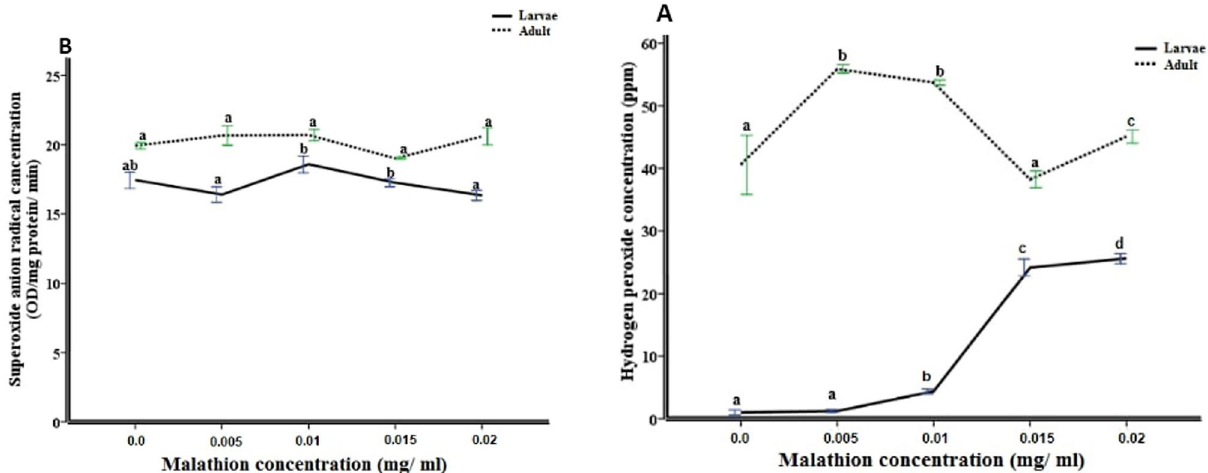
Figure 1. Reactive oxygen species (ROS) concentration, that expressed as hydrogen peroxide (H 2 O 2 ) concentration ( A ), and superoxide anion (O 2 •- ) concentration ( B ). The data were expressed as mean ± SE. The concentrations were obtained from gut homogenates of 5th instar larvae and males of Hermetia illucens , which their food containers were exposure to different concentrations of malathion (0, 0.005, 0.01, 0.015, 0.02 mg/ ml). Mean values marked with the different lowercase letters were significantly different among malathion concentration assessment (ANOVA test Tukey’s-b , Post Hoc test, p < 0.05).